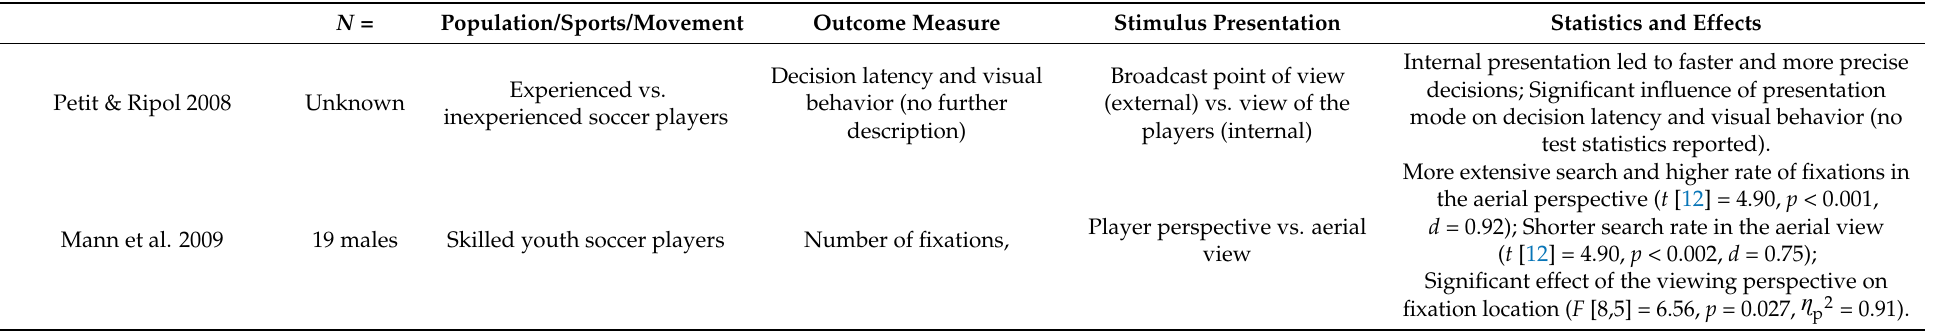
Table 2. Articles that thematize different perspectives in video